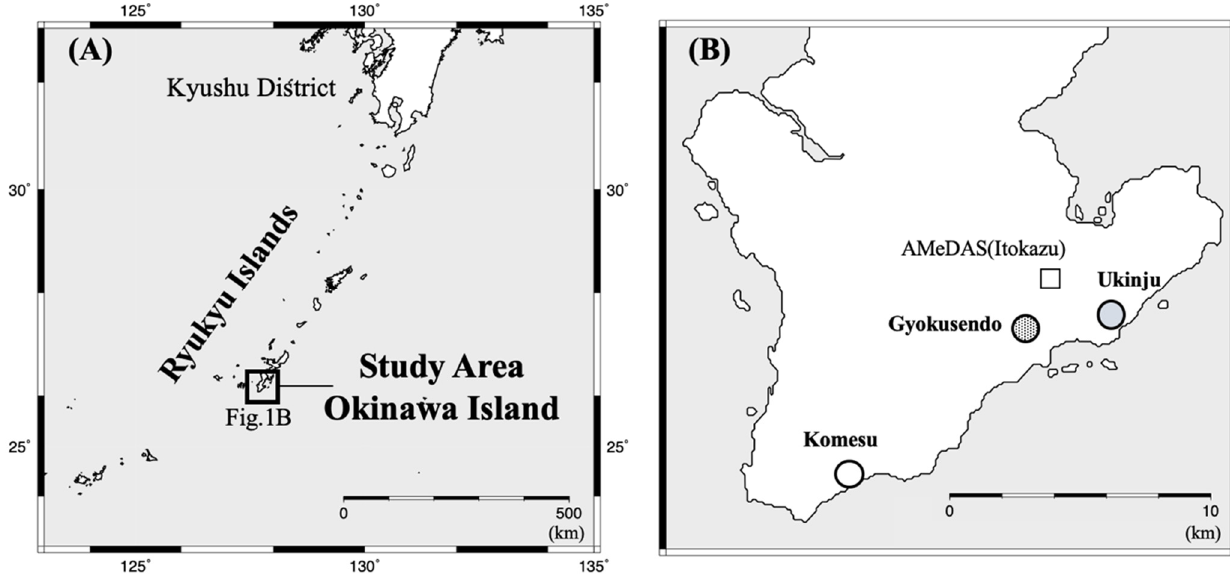
Figure 1. Locations of the study area ( A ) and sampling sites ( B ). The white square shows the Automated Meteorological Data Acquisition System (AMeDAS) situated at Itokazu.